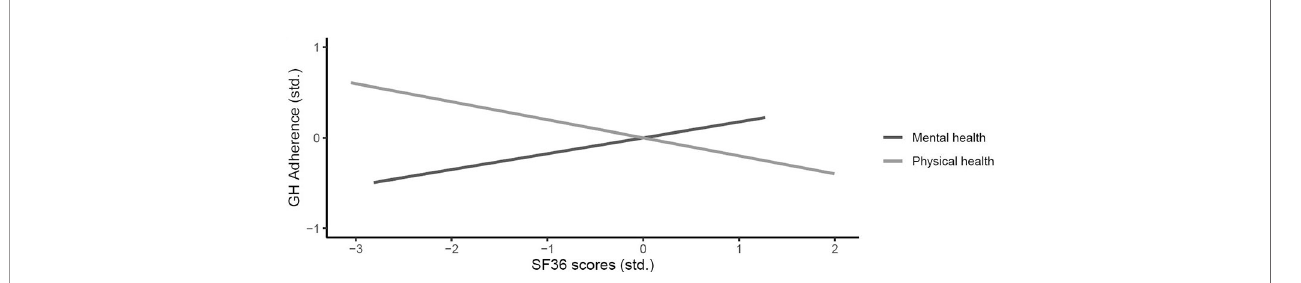
FIGURE 2 | Correlation between GH-speci fi c adherence and the SF-36 sum scores